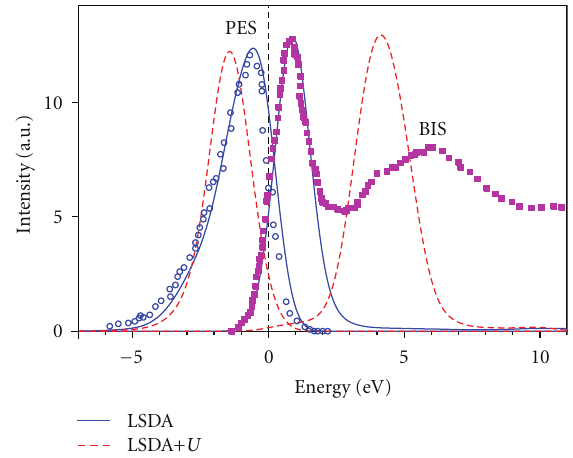
Figure 45: Comparison of the experimental photoemission (open circles) [287] and X-ray bremsstrahlung isochromat (full squares) spectra [287] with the 4 f partial DOS calculated by the LSDA (full line) and LSDA+ U (dashed line)